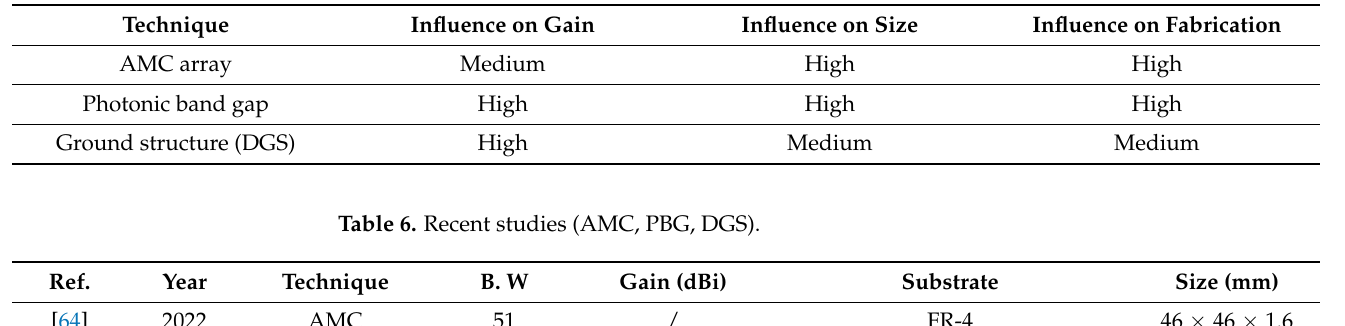
Table 5. Techniques Comparison.